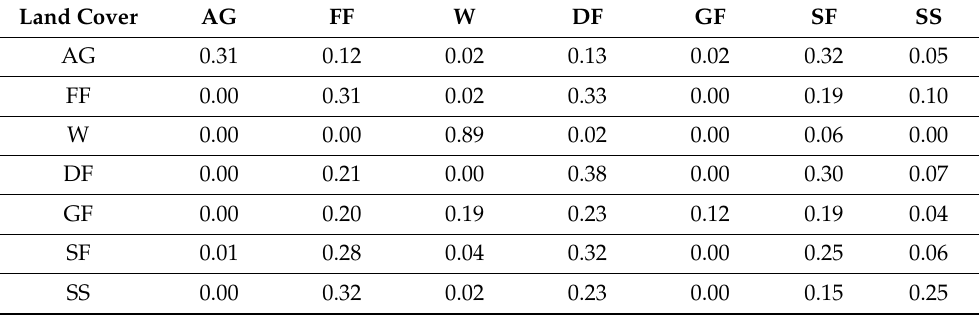
Table 7. Probability of changes from one class to